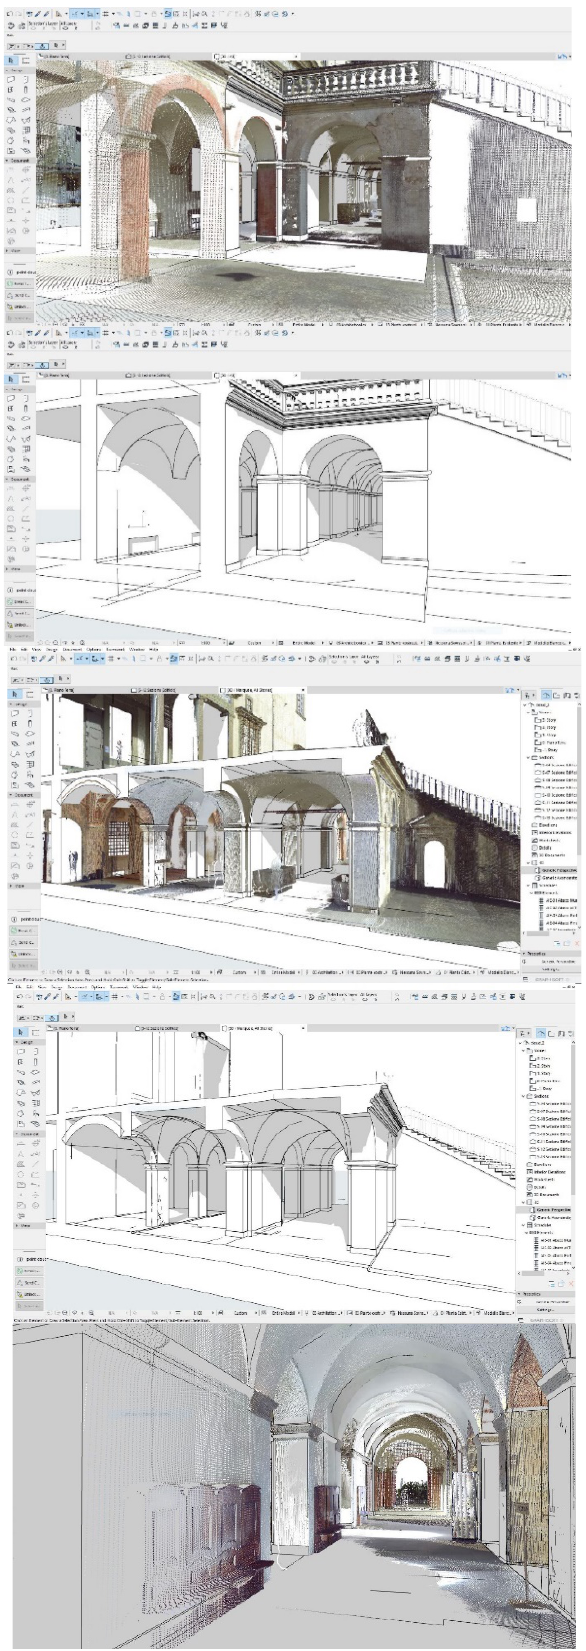
Figure 8: final model of the entrance ceilings and section vaulted modelling Point-cab, Grasshopper,